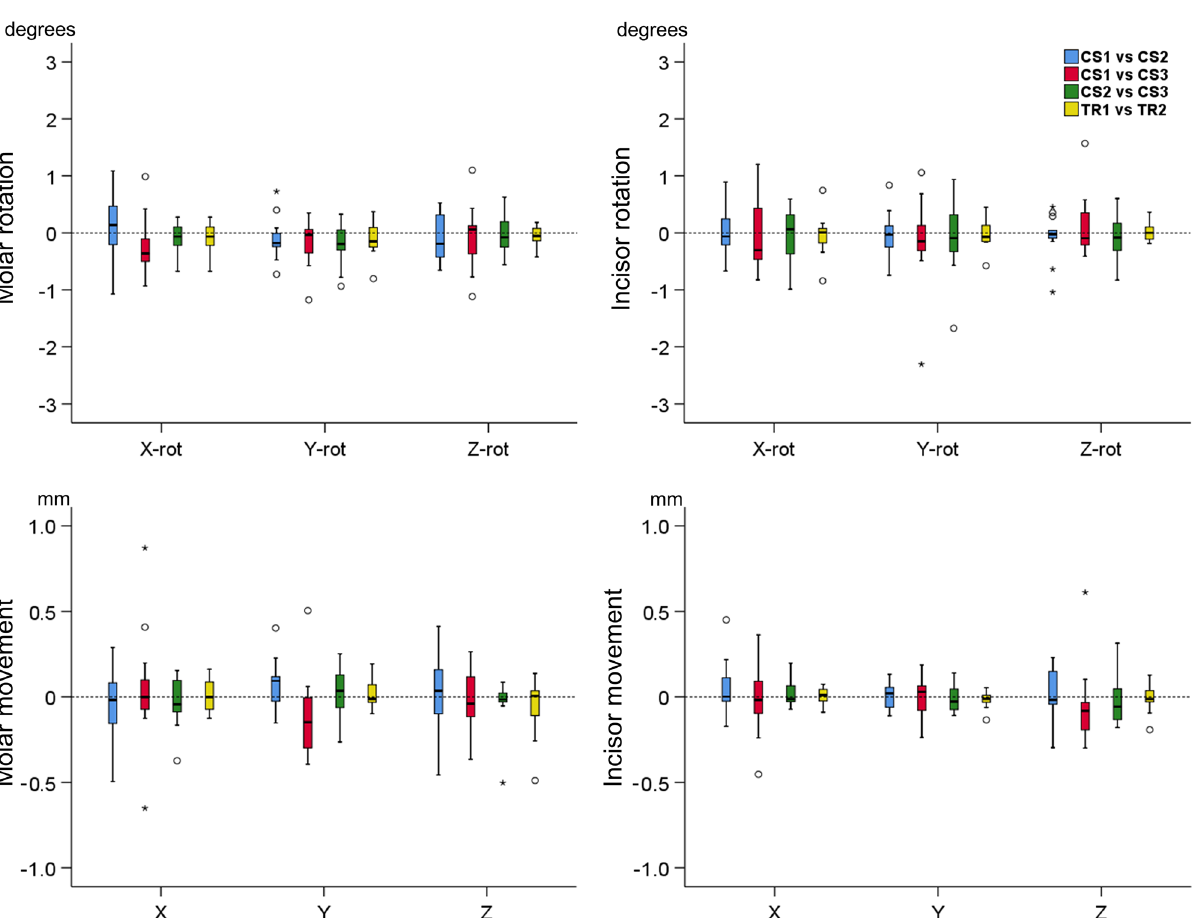
Figure 8. Box plots showing the positional changes of the two teeth of interest (a first molar and a central incisor) in all three planes of space, measured after superimposition of repeated scans on palatal area A (mm for movements, ° for rotations; Friedman test, p > 0.05). The upper limit of the black line represents the maximum value, the lower limit the minimum value, the box the interquartile range, and the horizontal line the median value. Outliers are shown as circles or stars, in more extreme cases. CS1, CS2, CS3: CS3600 repeated scans. TR1, TR2: TRIOS3 repeated